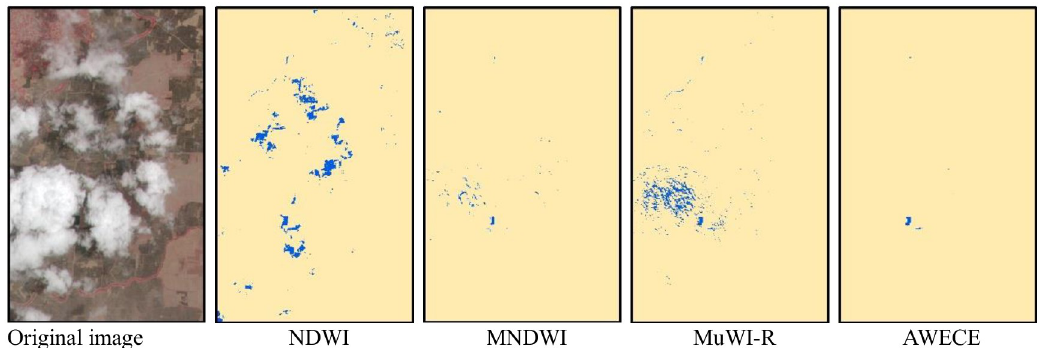
Fig 9. Water extraction results of different models under extremely complex